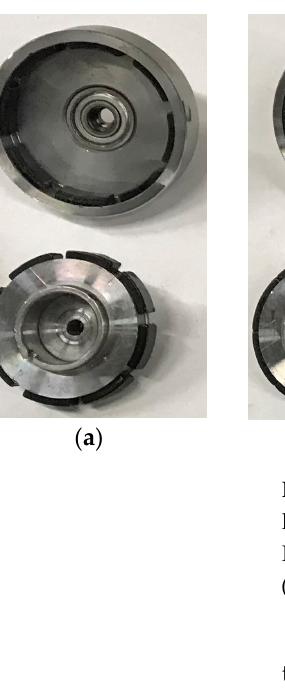
( b ) Figure 22. Assembly of ( a ) MC for dynamic tests; ( b ) MC with piston engine and propeller. The operation principle of the direct dynamic test system shown in Figure 23a is as follows: The MC (3) device under test (D.U.T) is driven by a geared induction motor (4) with a high torque capacity. Dynamic tests are performed by gradually or directly loading the hysteresis brake for 1 h for each set of tests (1), depending on the type of test, such as no-load, rated-load, or overload. At this stage, as the load changes, the output torque and speed are measured by the torque/speed transmitter (2) and recorded by the panel. In the thrust test system shown in Figure 23b, the load cells and sensors are used to measure the force, thrust, and temperature while the PE is operated at idle speed, cruising speed, and overspeed. The sensors and transducers in the test systems are calibrated by